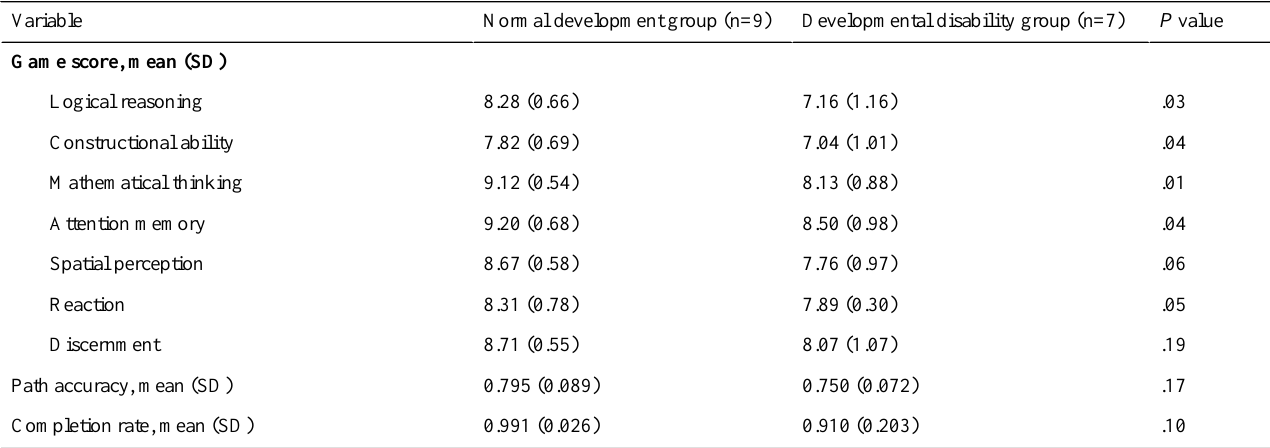
Table 2. Comparison of the game-derived index between the normal development and developmental disability groups.